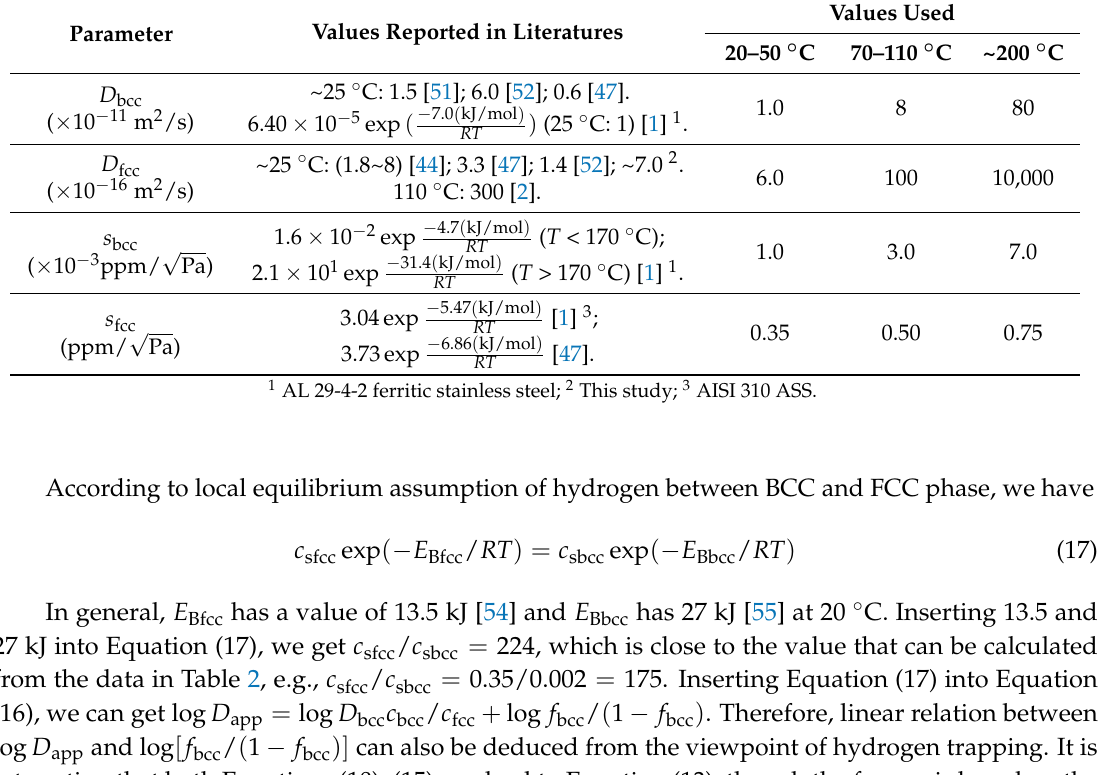
Values Used 20–50 ◦ C 70–110 ◦